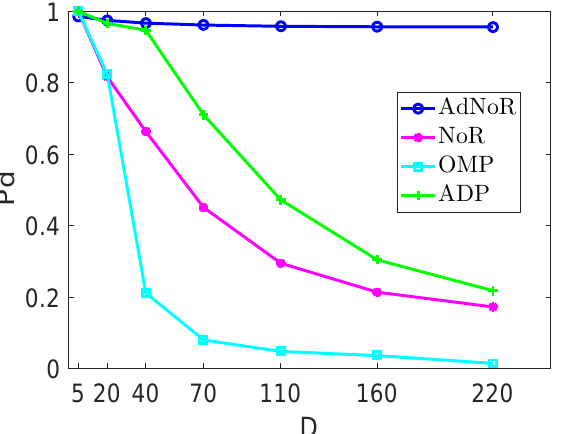
Figure 3. Detection Probabilities of the four sensing algorithms with different number of active subbands D = 5,20,40,70,110,160,220, and with U = 360, N = 8, N / M = 2, P = 180, SNR = 10 dB.